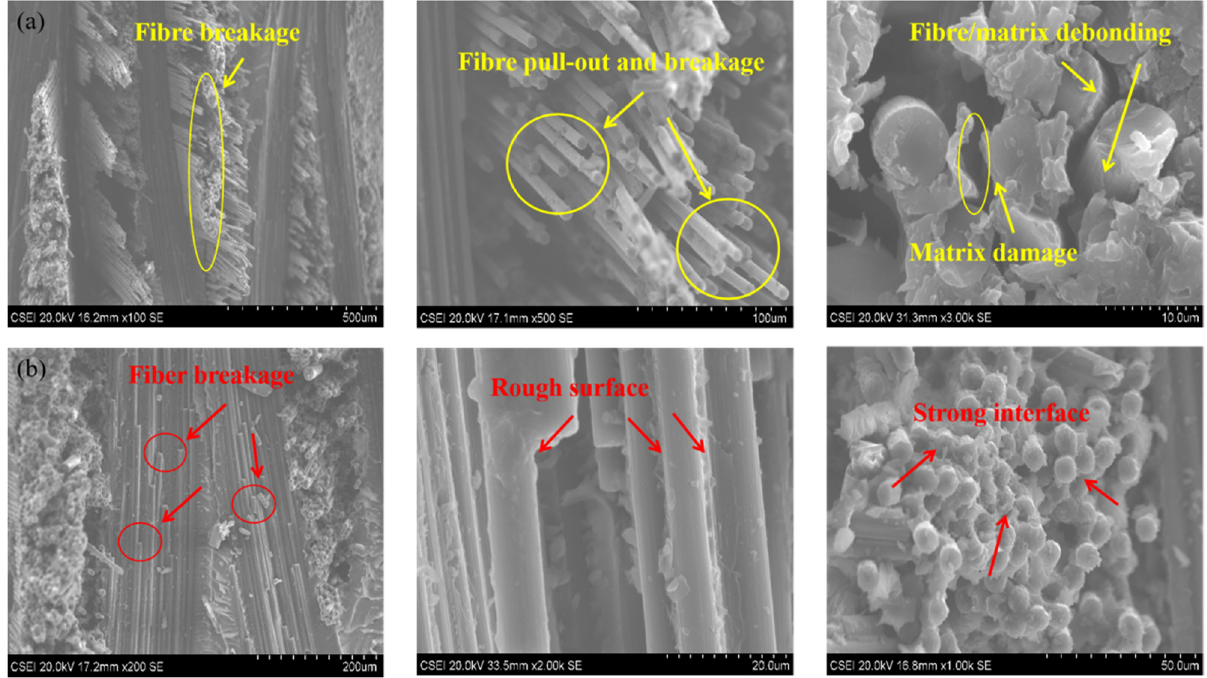
Figure 10: SEM images of specimens under fl exural loads. Specimens ( a ) A and ( b )